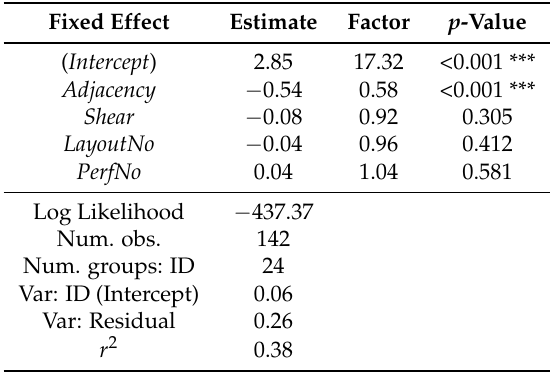
Table 3. Generalized linear mixed effects model for immediate retention of the scale task.